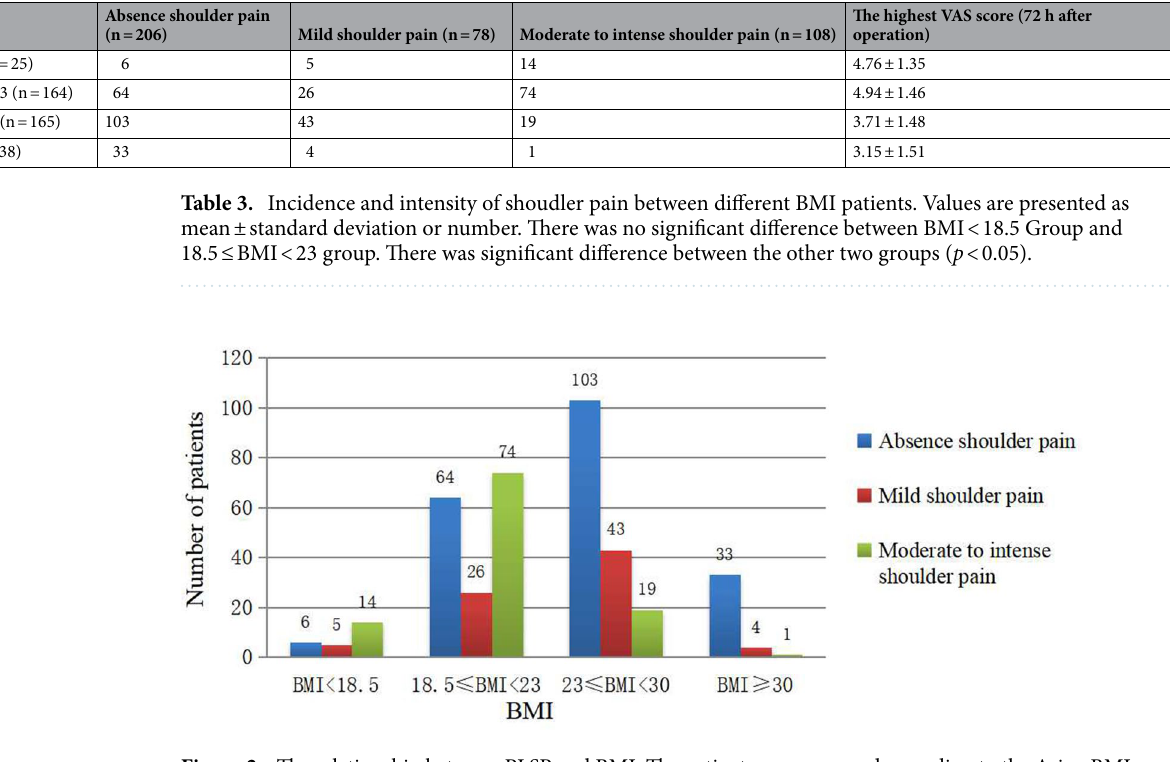
Figure 2. The relationship between PLSP and BMI. The patients were grouped according to the Asian BMI standard. The distribution of the number of people with different degrees of shoulder pain in each group.